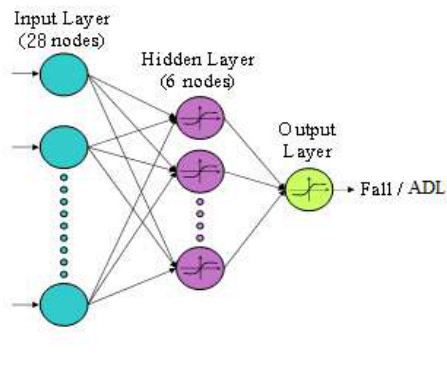
Fig. 8. The structure of proposed MLP